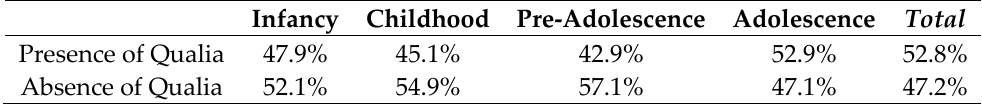
Table 3. Marker “Qualia”: percentages on the total number of the drawing